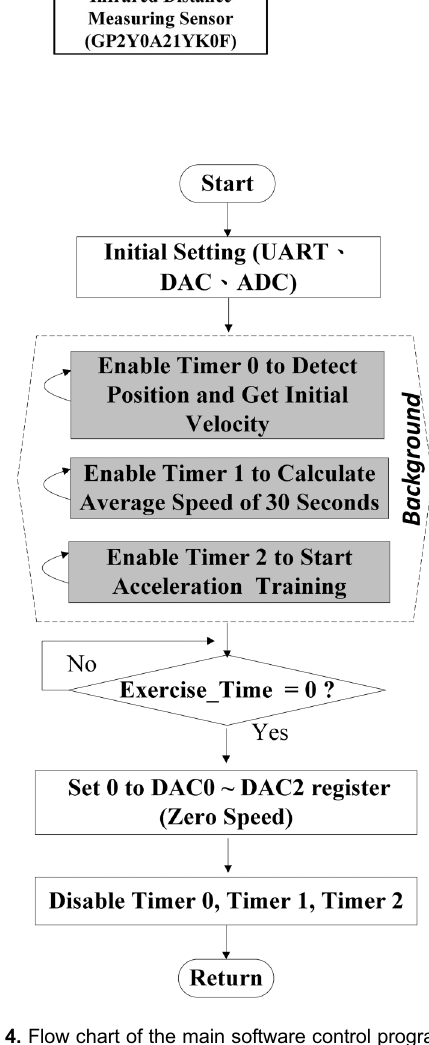
Figure 4. Flow chart of the main software control program of the automatic climbing